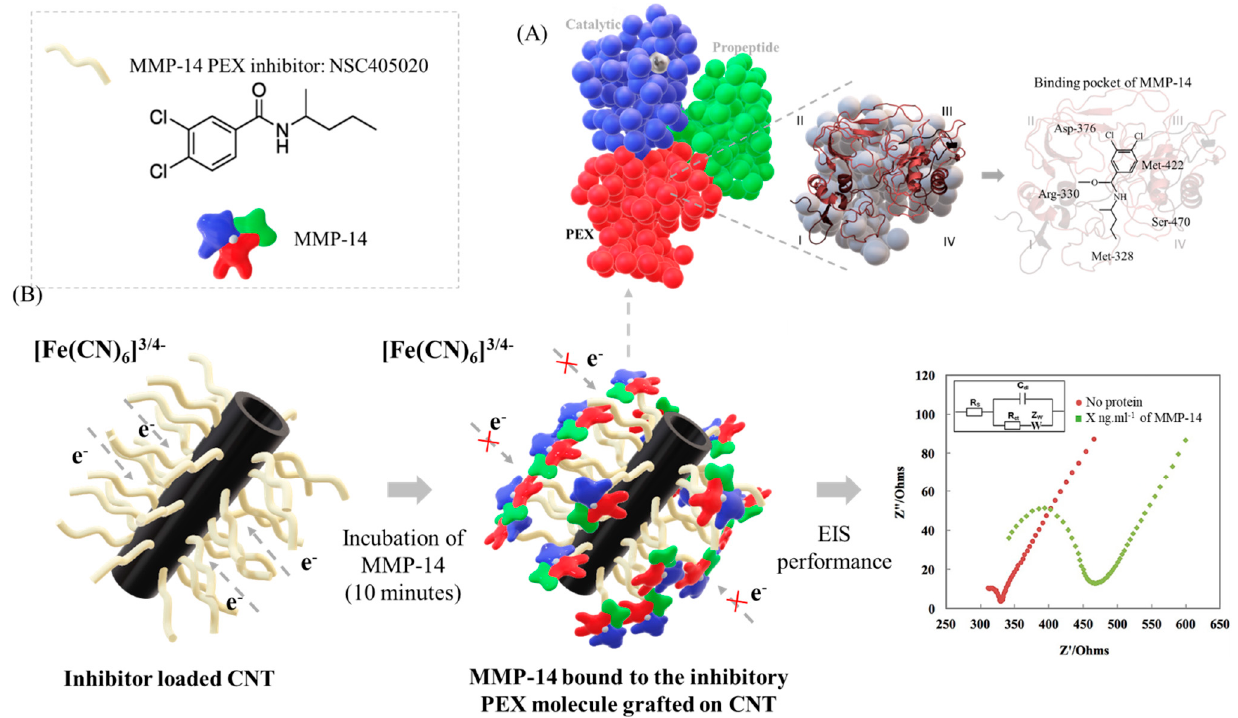
Figure 4. ( A ) The inhibitor/protein interaction between small molecule NSC 405020 and the binding pocket of MMP-14 and ( B ) Schematic of the MMP-14 detection through the binding mechanism of protein and inhibitory small molecule as the recognition